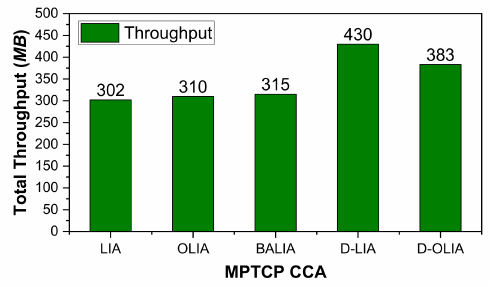
Figure 5. Performance analysis of the considered MPTCP-CCAs for Scenario #1 in terms of total